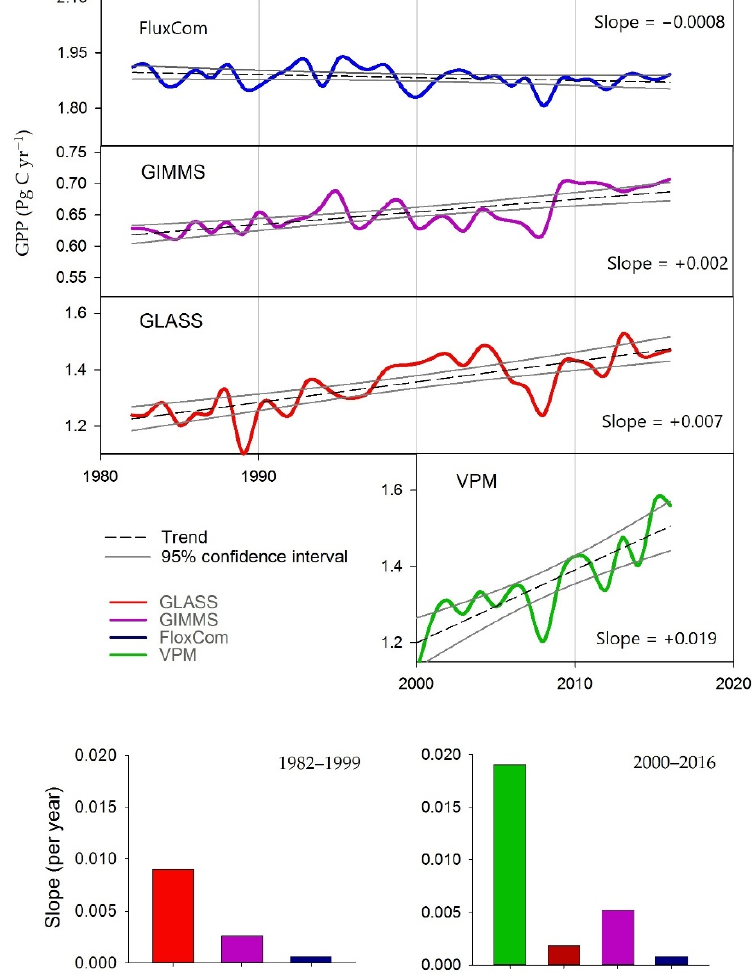
Figure 4. Temporal trends of the regional carbon stocks (in PgC yr − 1 ) for the Middle East between 1982 and 2016. 1 PgC = 10 15 gC. Grouped bars on the bottom row indicate the magnitude of change for the two short sub-periods (1982–1999 and 2000–2016). The black lines are the statistical confidence interval (95%) of the regression